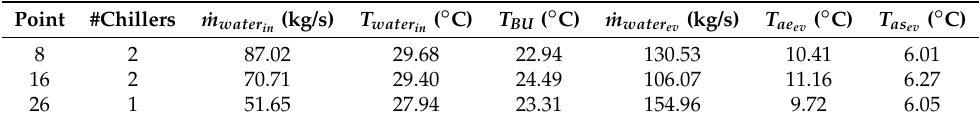
Table 3. Collected data for the operational points used to discuss the performance of the optimiza- tion